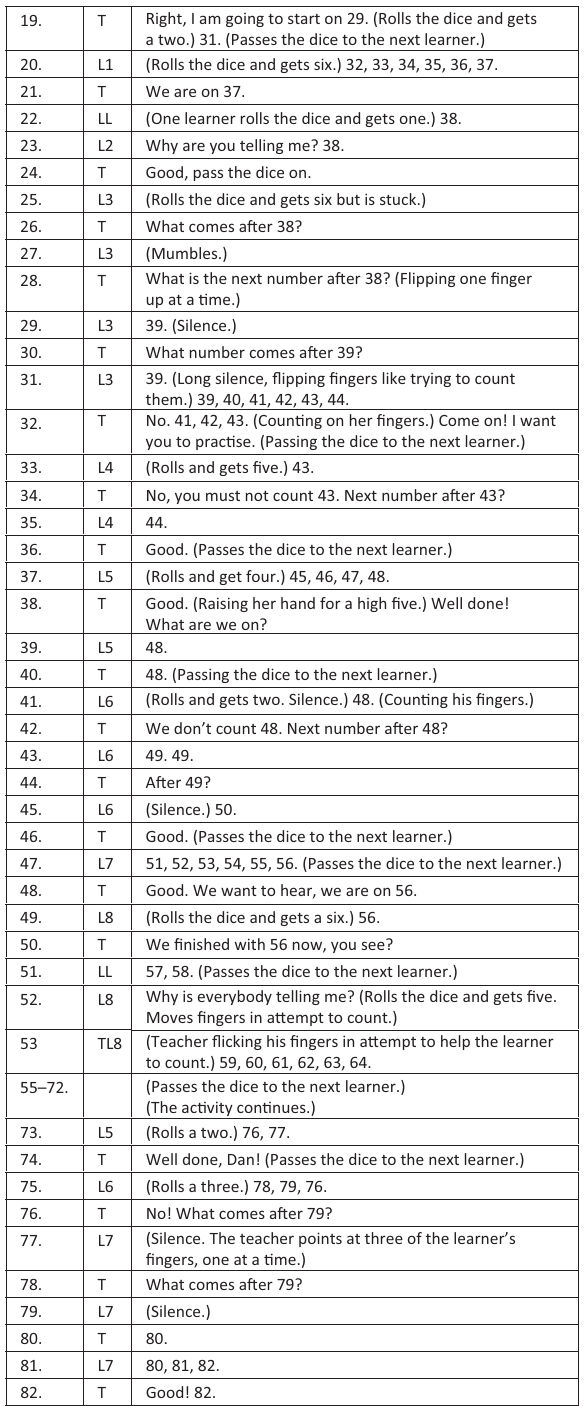
FIGURE 1: Excerpt showing the challenges learners face in bridging the decades. T, Teacher; L, learner; LL, learners; TL1, teacher and Learner